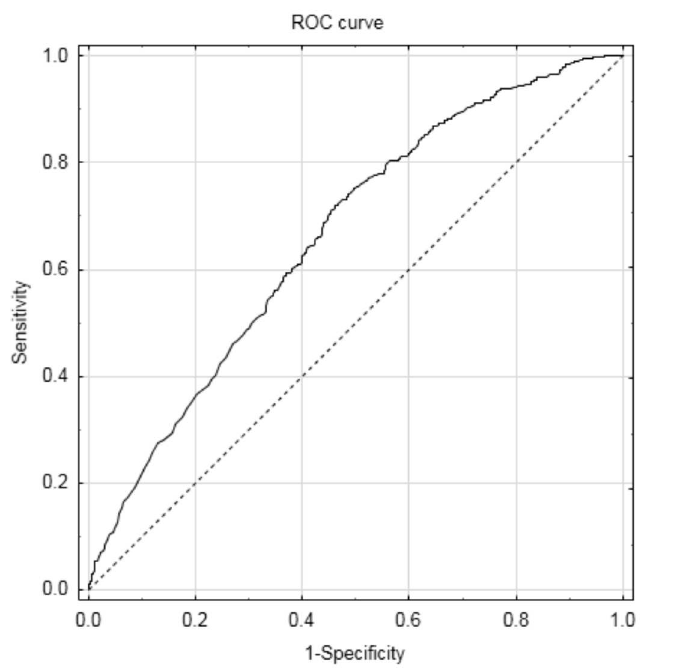
Figure 1. The ROC Curve for the created artificial neural network model